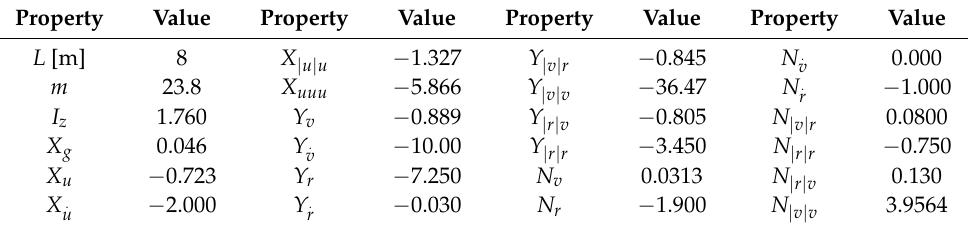
Table 2. USV performance parameters settings.